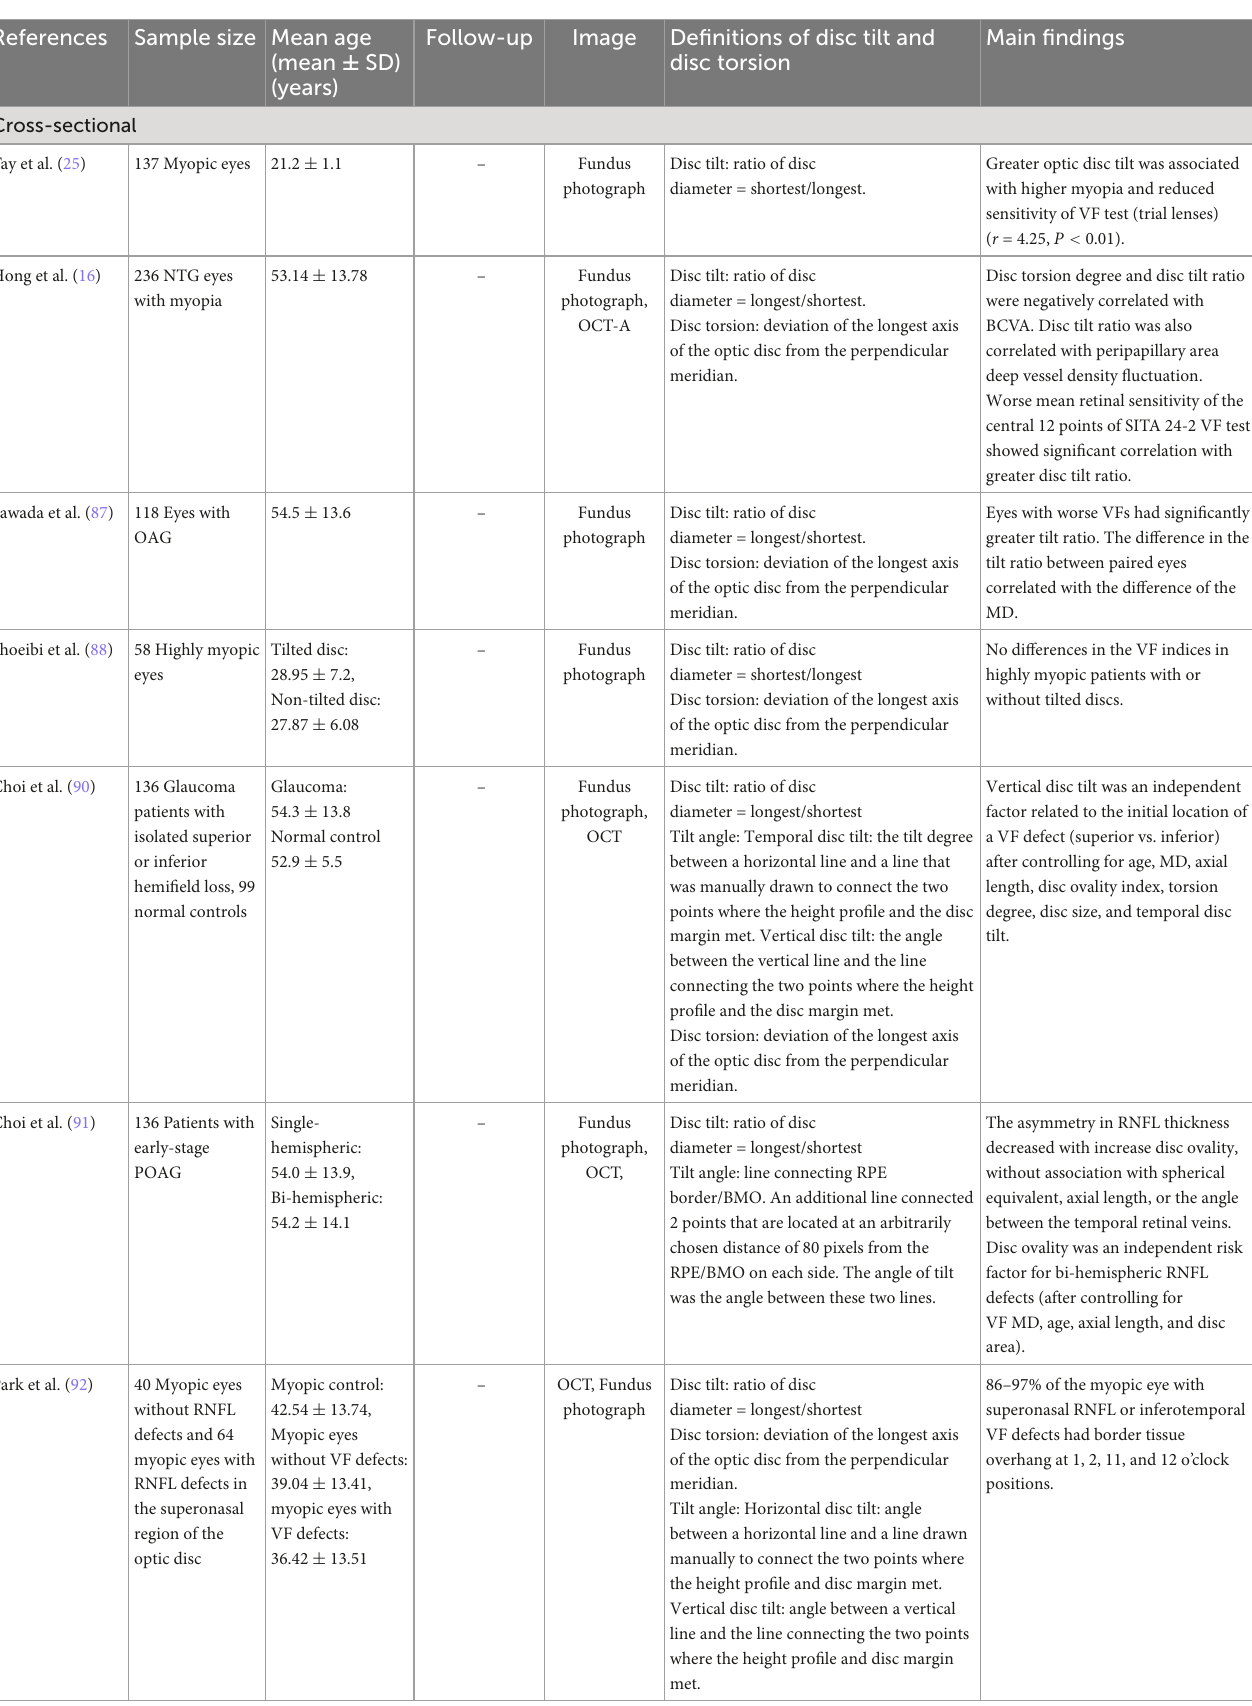
TABLE 3A Functional change related to disc tilt.